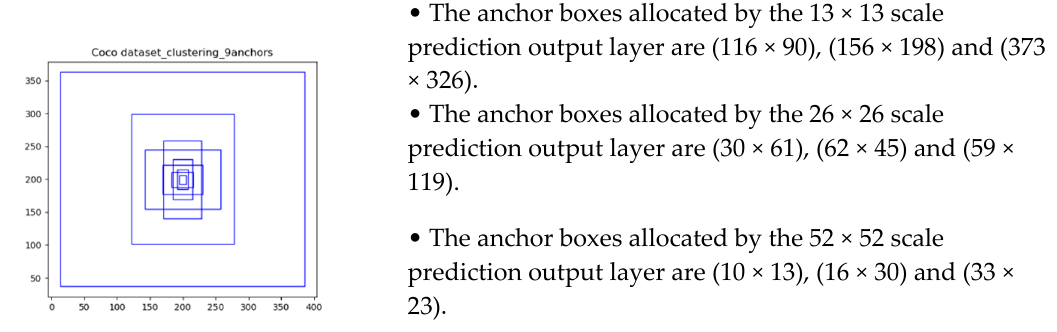
Figure 3. Size and distribution diagram of the nine anchors of COCO dataset.